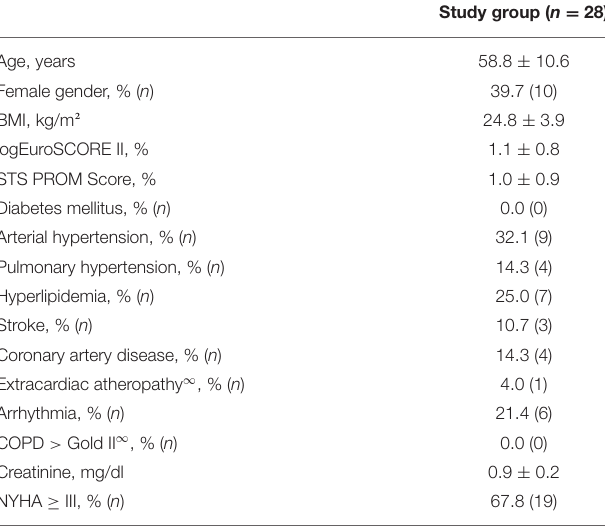
TABLE 1 | Baseline